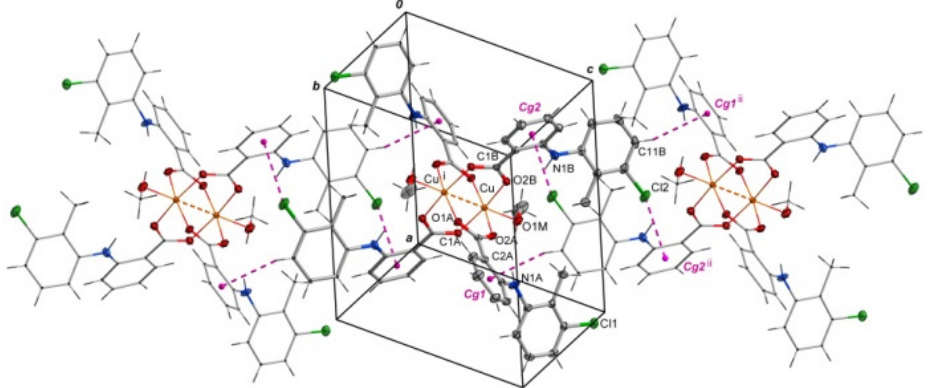
Figure 3. Arrangement of molecules of [Cu II 2 (Tolf) 4 (MeOH) 2 ] in a chain where adjacent molecules contact via Cl ··· π and C–H ··· π interactions. For clarity, uncoordinated methanol molecules were removed. Symmetry codes: i = − x + 1, − y + 1, − z + 1; ii = 1 − x, − y, 2 − z. Table 2. Selected bond lengths in [Cu II2 (Tolf) 4 (MeOH) 2 ] ∙ 2MeOH.